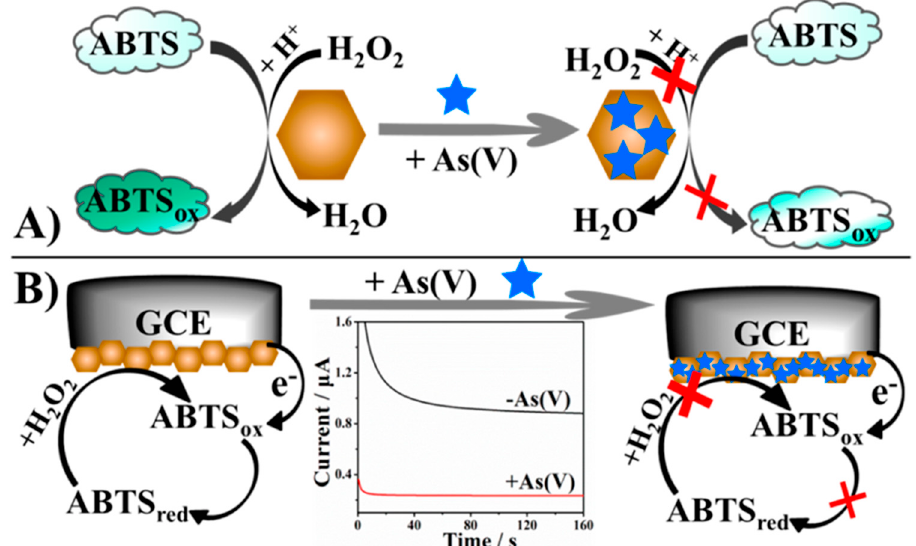
Figure 16. Scheme of arsenate sensors based on CoOOH nanoflakes with POD − like activity: ( A ) illustration of the colorimetric method; ( B ) illustration of the electrochemical strategy [116]. Copyright: American Chemical